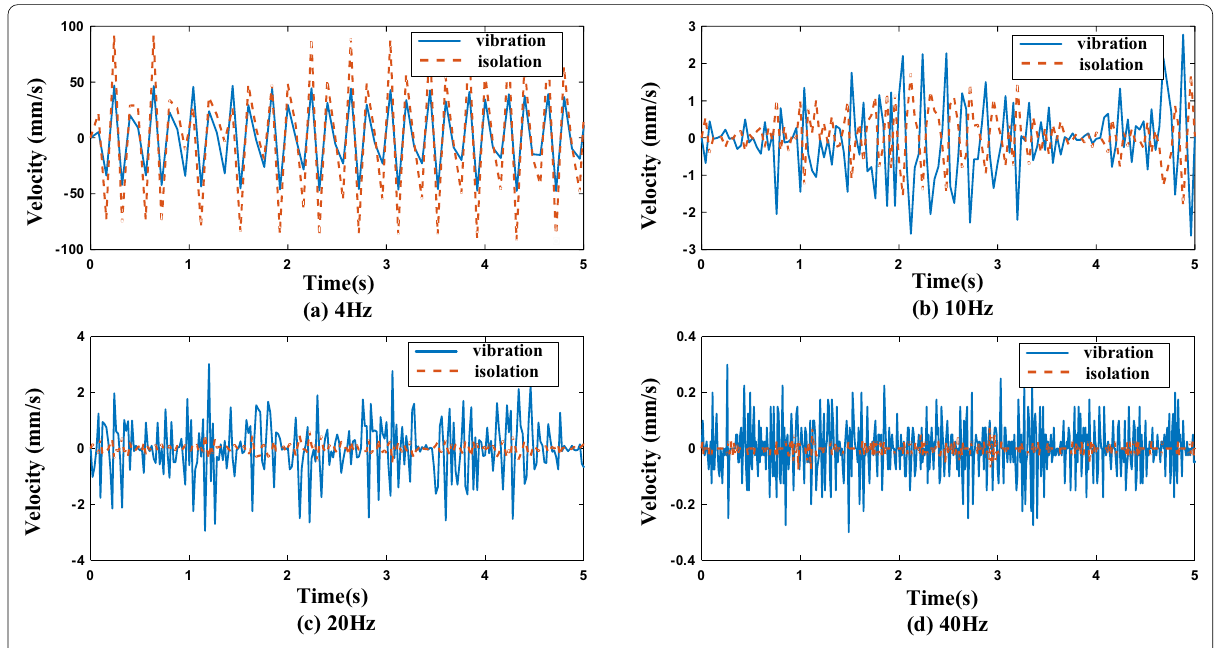
Figure 13 Isolator performance under different frequency vibration in the second